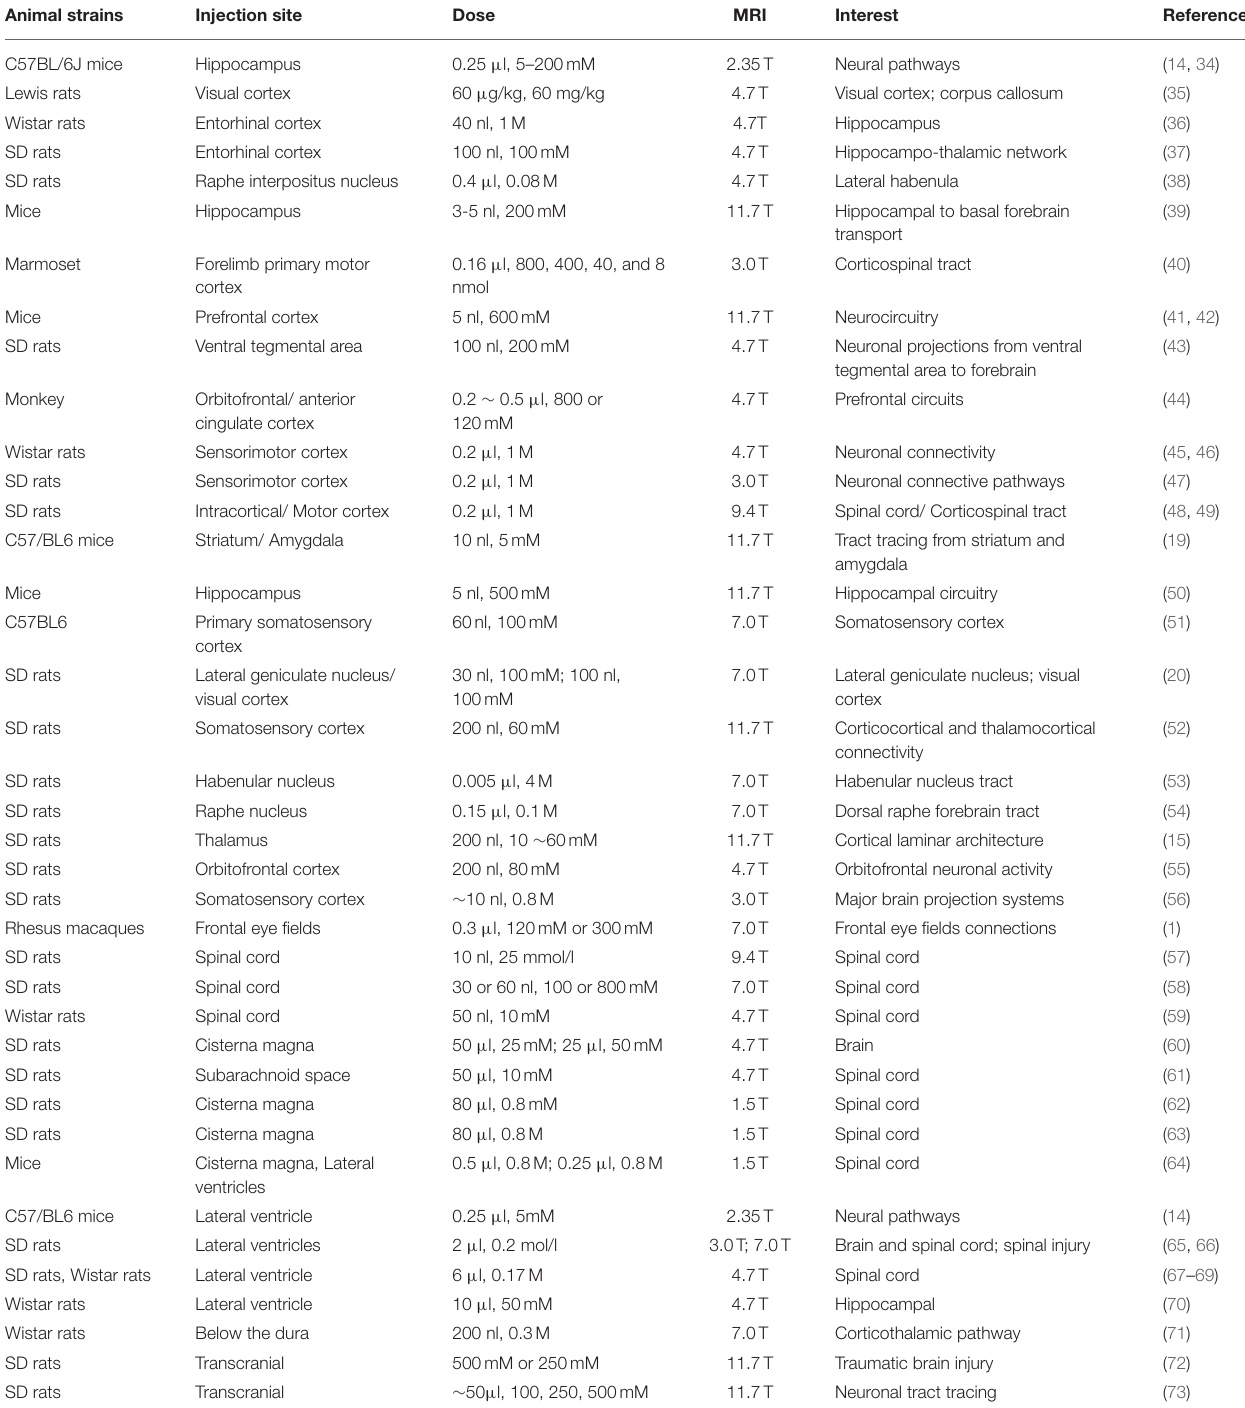
TABLE 1 | Summary of MEMRI studies using local administration of Mn 2 +